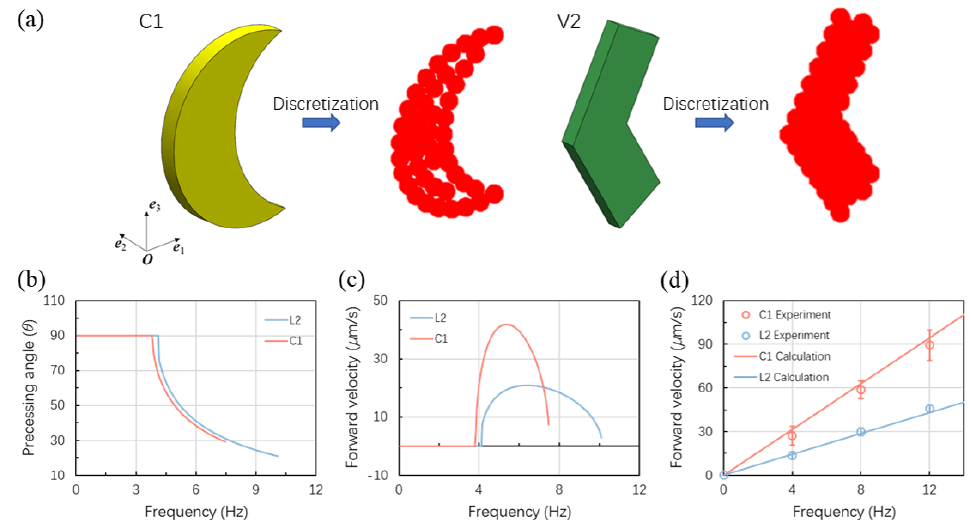
Figure 3. Calculation models and data. ( a ) Discretization of the C1 and V2 microswimmer into spheres. ( b ) Change of the precession angle with frequency for C1 and V2 microswimmers. ( c ) The forward velocity of the C1 and V2 microswimmers under different frequencies. ( d ) The predicted forward velocities with experimental data for C1 and V2 microswimmers with a 45 ◦ precession angle were maintained under different frequencies. Red lines and symbols are for C1 microswimmers and the blue ones are for V2 microswimmers from ( b – d